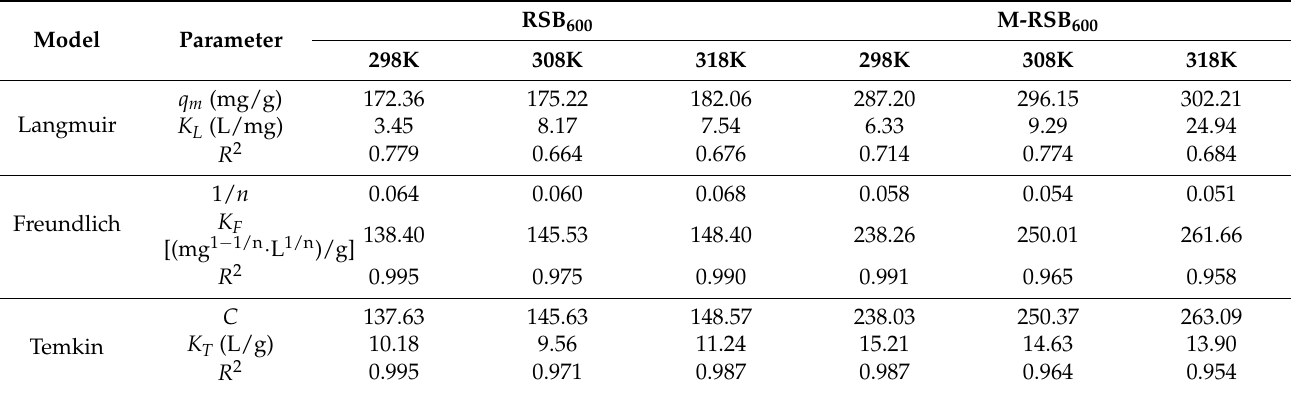
Table 5. Isothermal adsorption fitting parameters of RSB 600 and M-RSB 600 for MB.